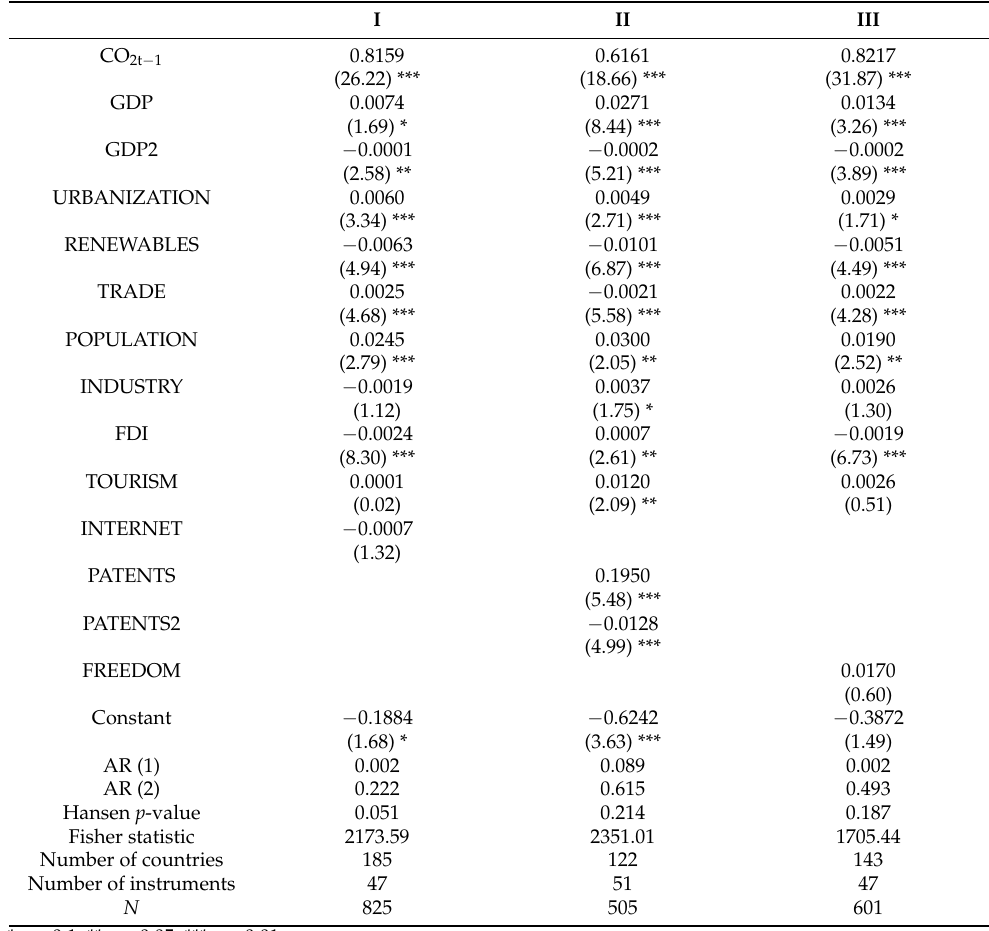
Table 4. Robustness